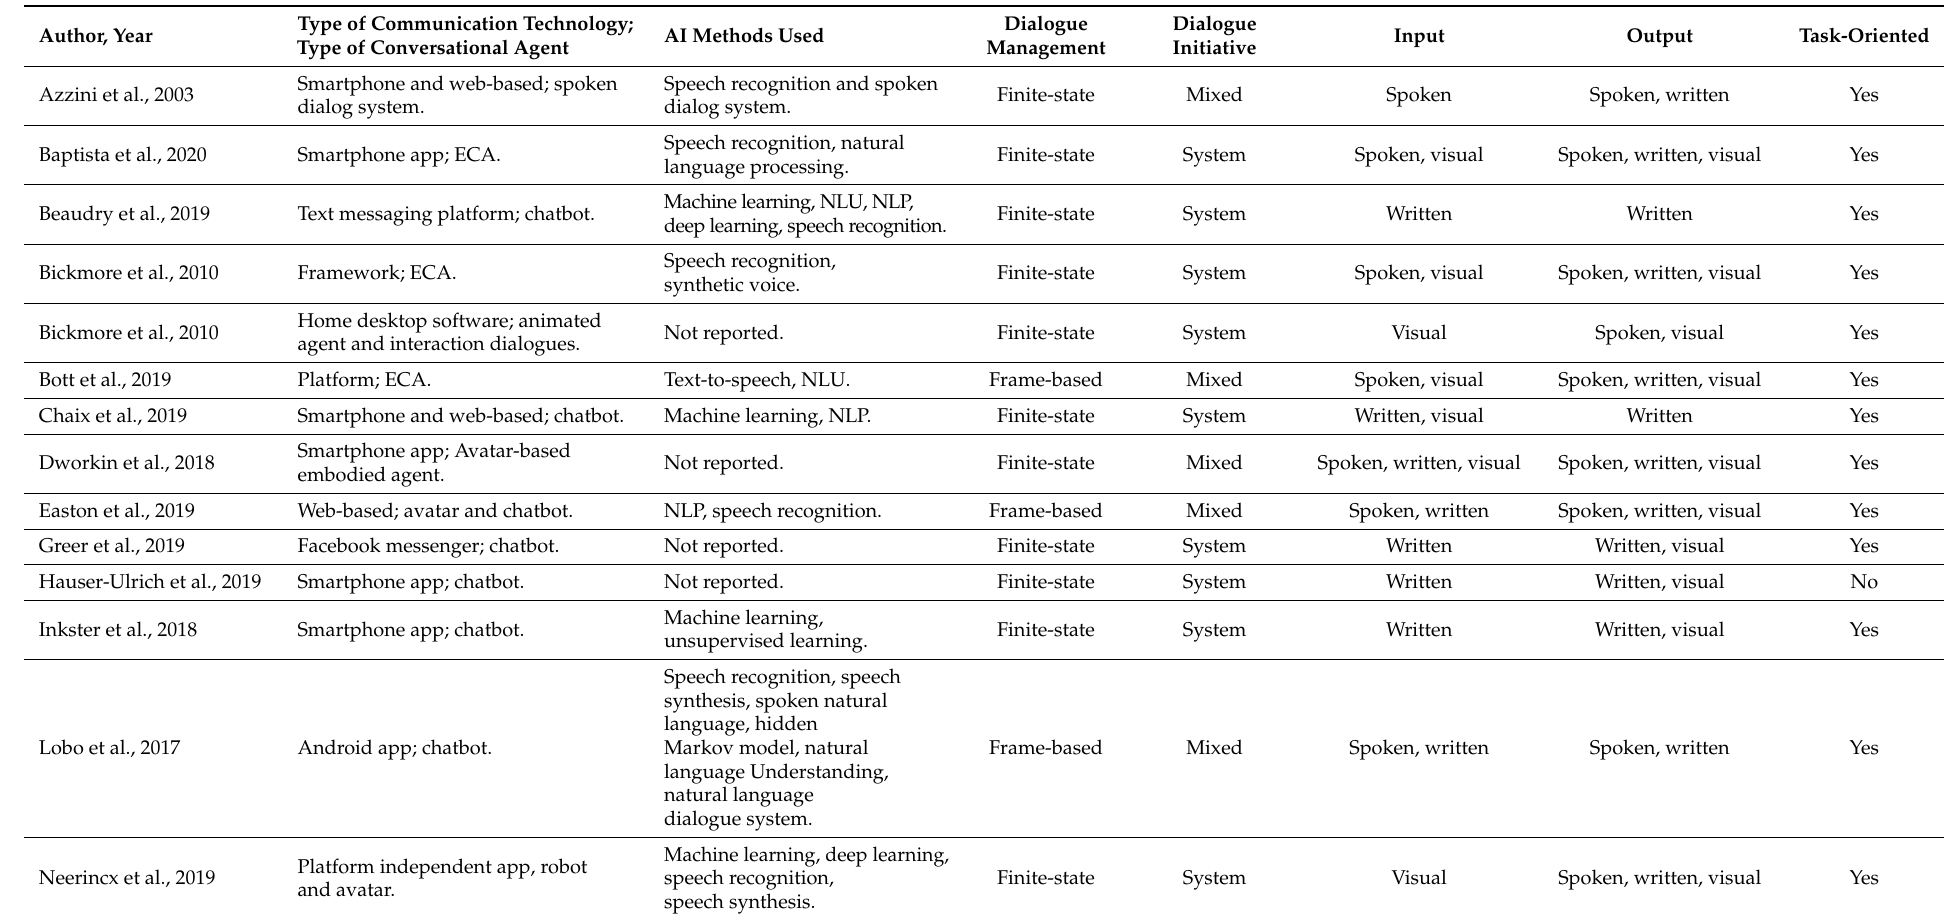
Table 2. Characteristics of the conversational agents evaluated in the included